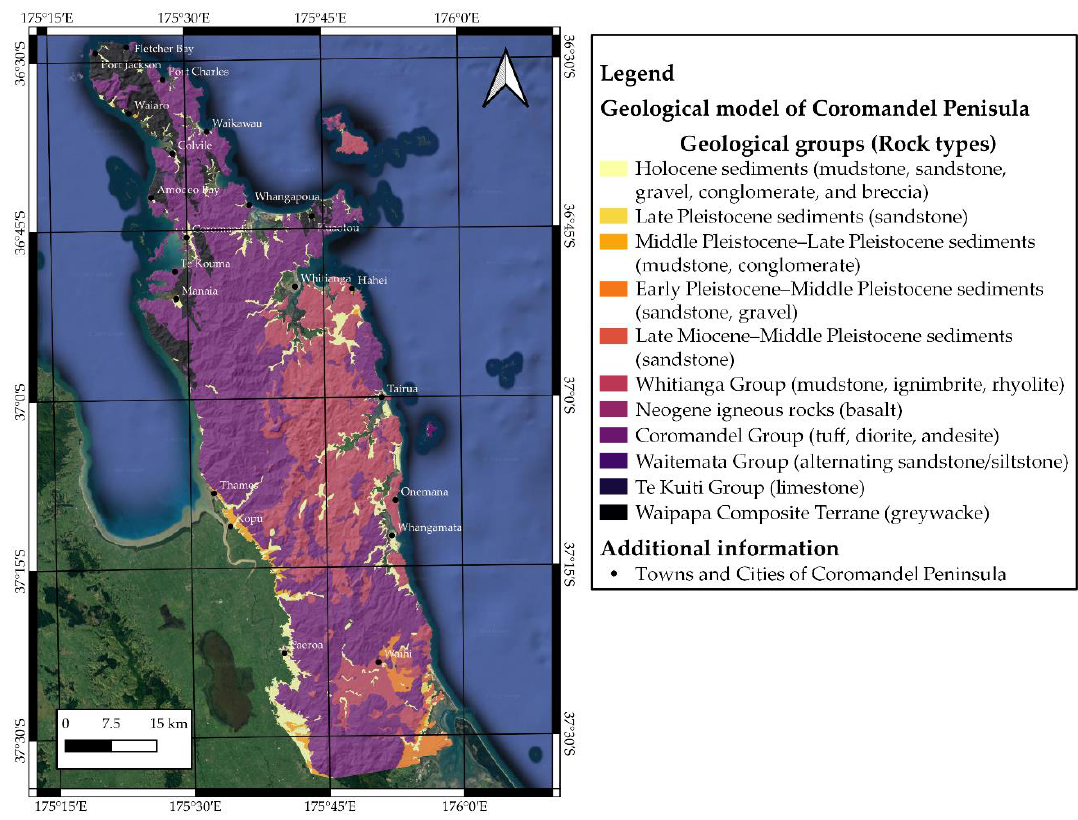
Figure 2. Geological model of Coromandel Peninsula based on the 1:250,000 scale New Zealand Geological Map (Q-Map Series—https://www.gns.cri.nz/data-and-resources/geological-map-of- new-zealand/, accessed on 20 August 2022) [36]; background is Google terrain map.